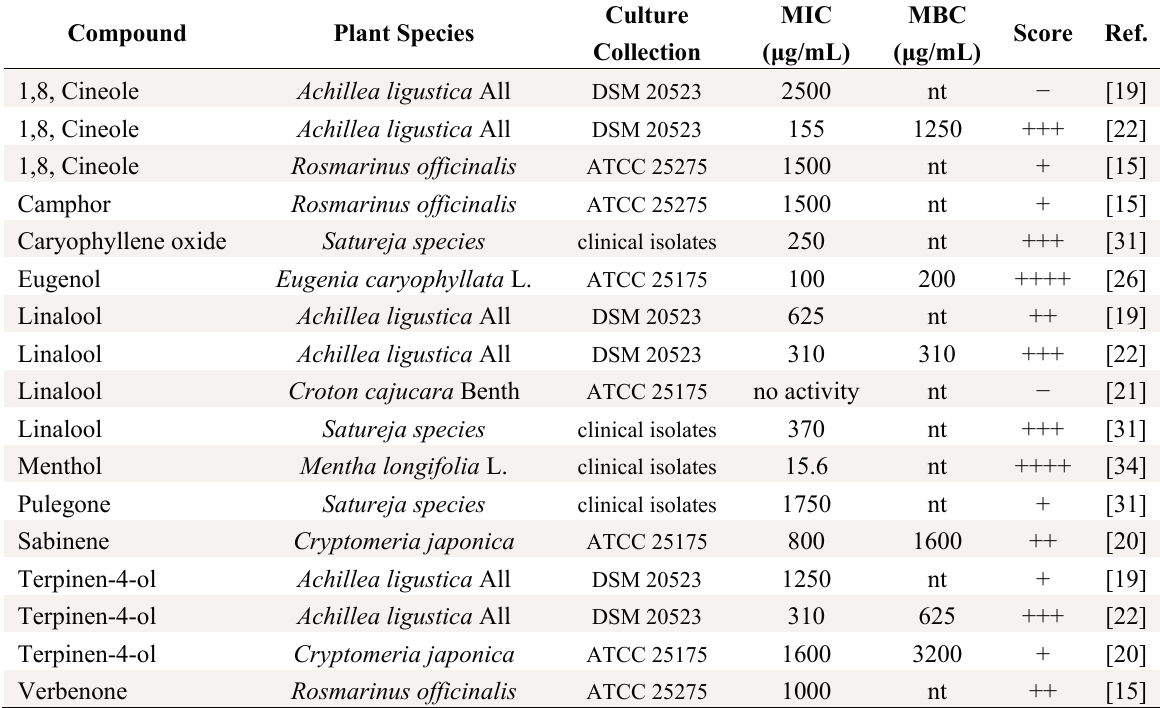
Table 4. Essential oils isolated compounds against Streptococcus mutans